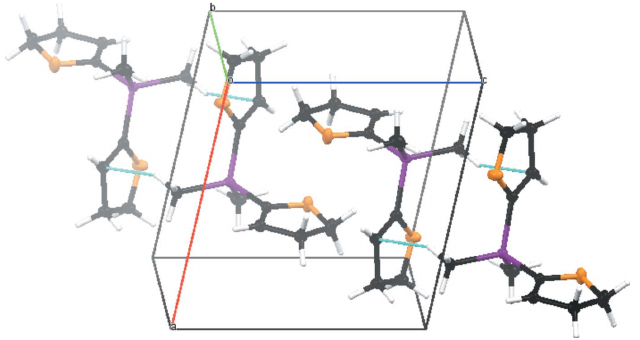
Figure 3 The crystal packing of compound 1 . C—H (cid:4)(cid:4)(cid:4) C van der Waals interactions are shown as dashed lines.